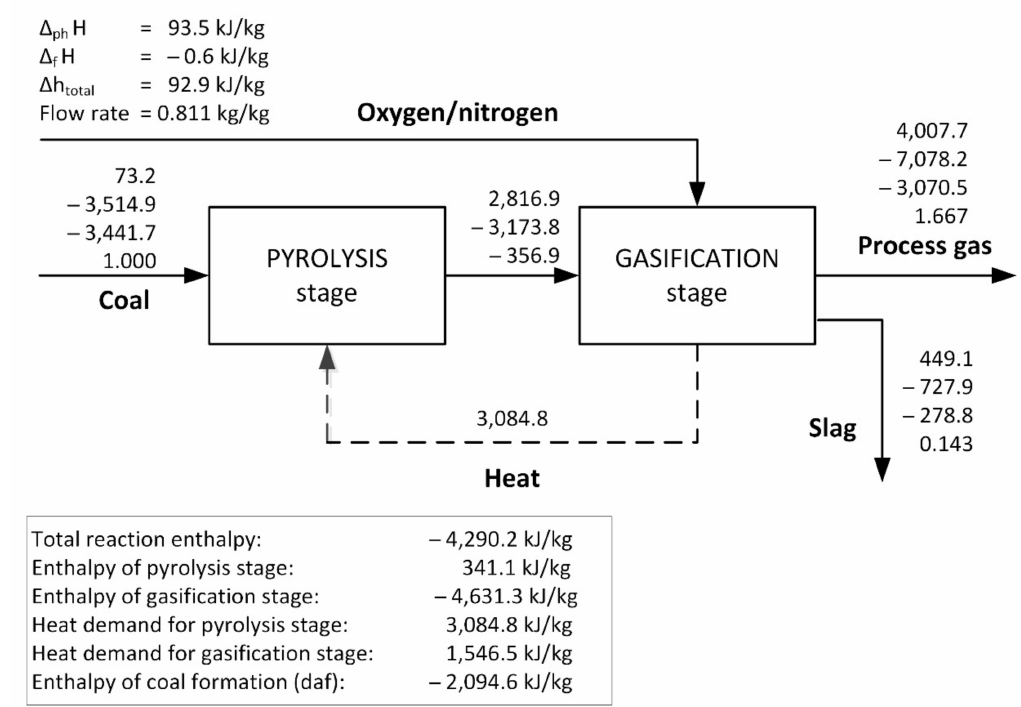
Figure 14. Energy balance of Shell process for lignite gasification per 1 kg of feed